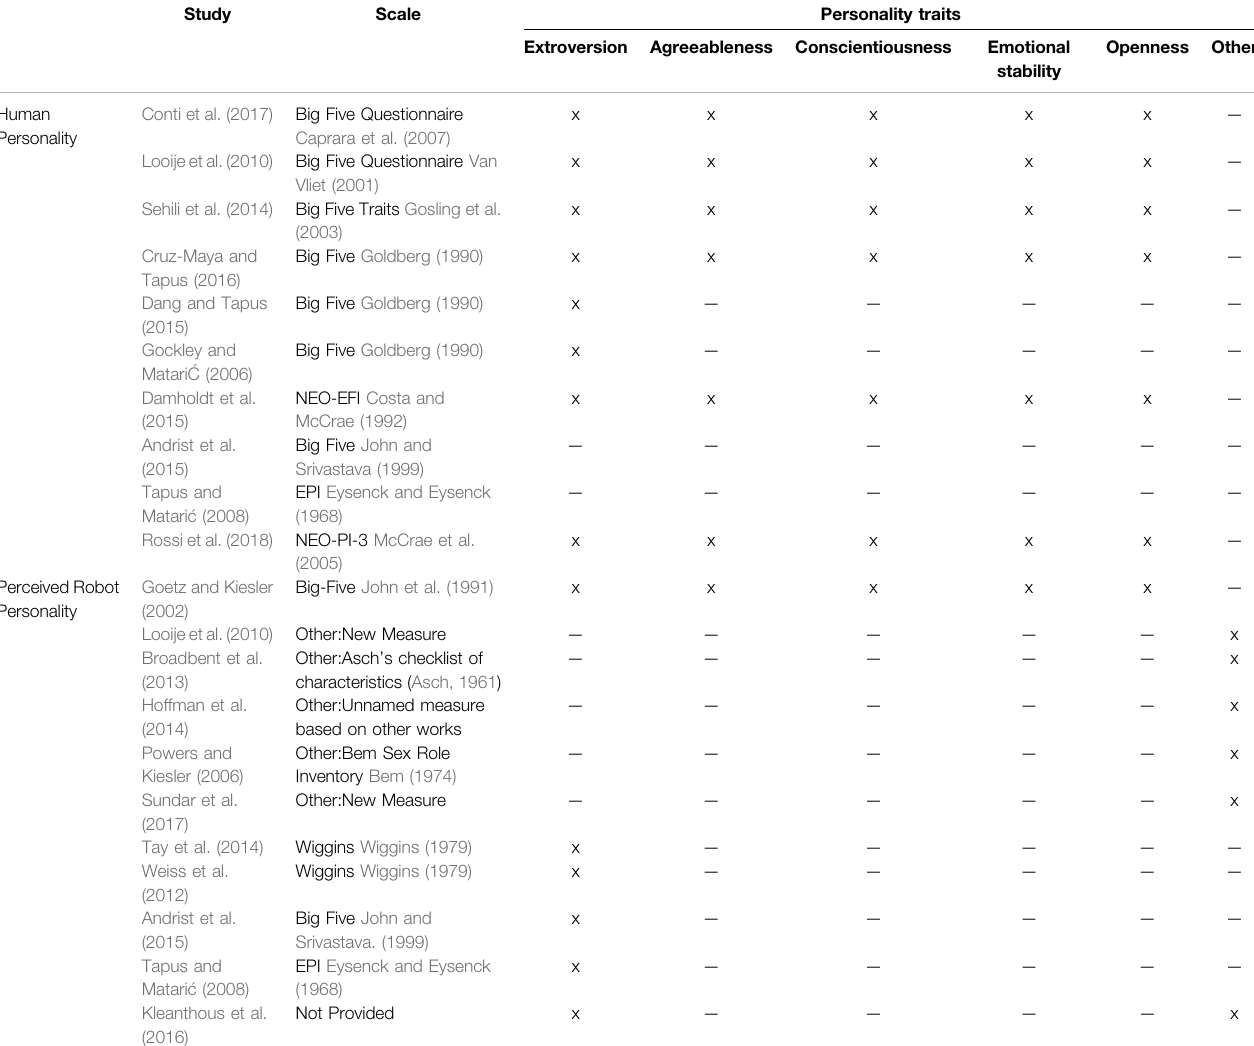
TABLE 4 | Personality traits and